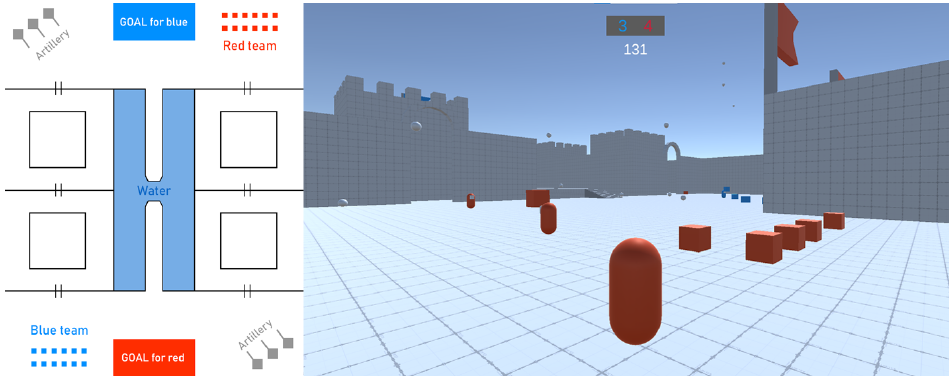
Figure 1. The game map ( left ) and an in-game screenshot ( right ).